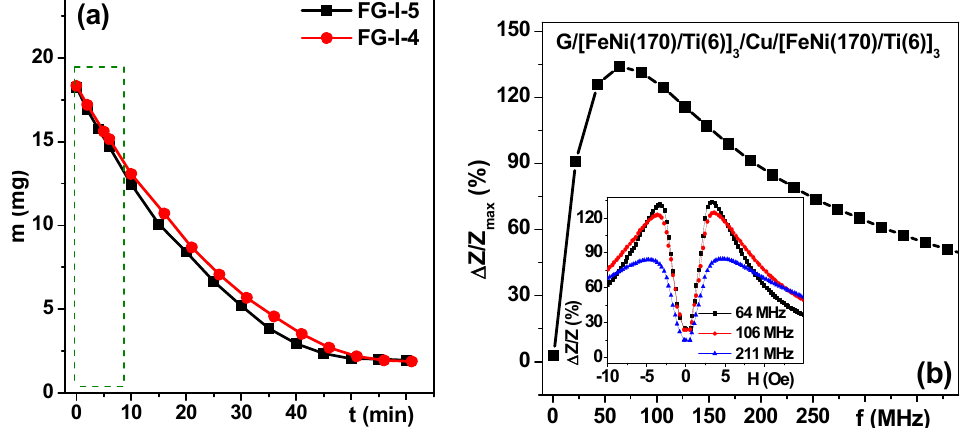
Figure 10. Mass loss for rectangular stripes of ferrogels used in MI measurements as a function of time drying in normal conditions ( a ); Frequency dependence of the maximum value of MI ratio ∆ Z max / Z for multilayered structure deposited onto glass substrate. Inset shows field dependence of the ∆ Z / Z ratio for characteristic selected frequencies. All units for the layers’ thickness are nanometers ( b ).